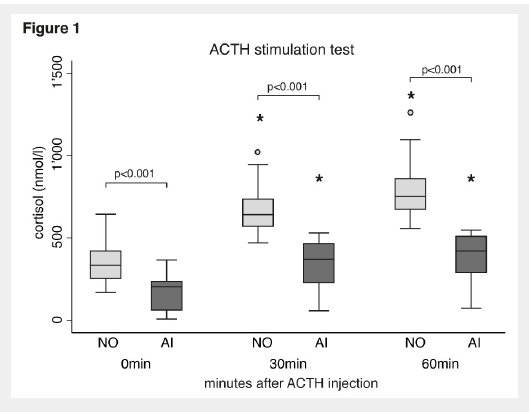
Cortisol values immediately before (0 min = baseline) and 30 minutes (30 min) and 60 minutes (60 min) after ACTH injection. Patients with adrenal insufficiency (AI) are plotted in dark grey; patients with normal adrenal function (NO) are plotted in light grey. * p <0.001 for comparison with baseline